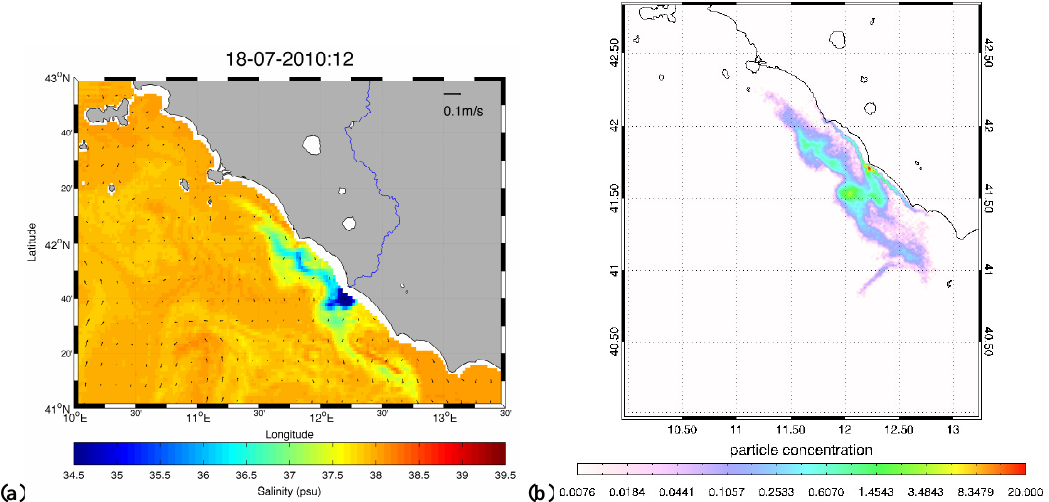
(a) (b) Fig. 10. (a) 18 July 2010, salinity at − 5m. (b) 18 July 2010, map of pollutant dispersion; units (gm − 2 ), logarithmic ( ) 35 Fig. 10a. 18 July 2010, salinity at –5 m. Fig. 10b. 18 July 2010, map of pollutant dispersion; units ( gm − 2 ), logarithmic scale. 34 Fig. 9b. 18 July 2010, map of K490 ; units ( m − 1 ), logarithmic scale.